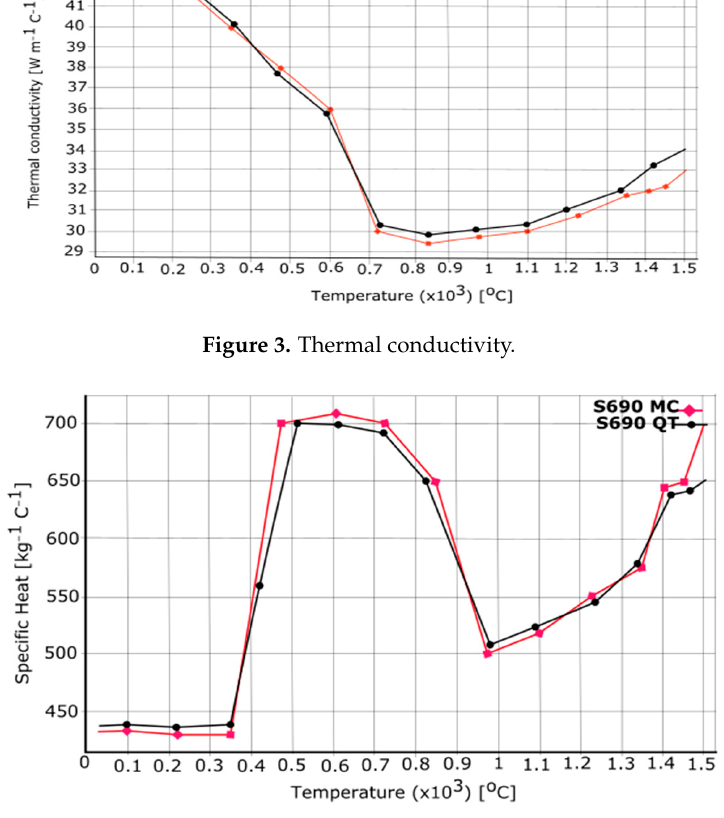
Figure 4. S pecific heat. Figure 4. Specific